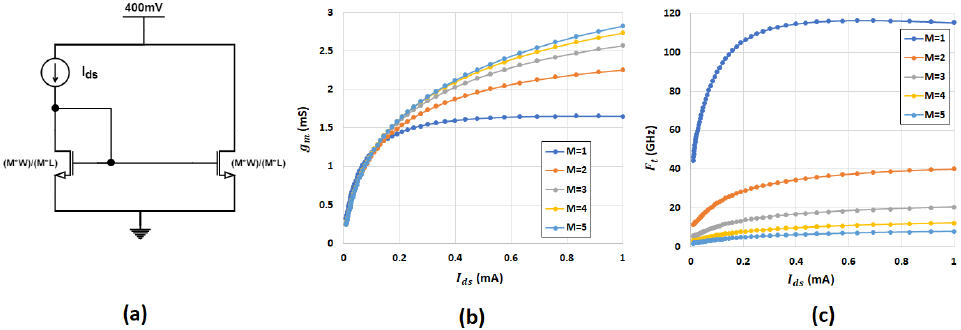
Figure 2. ( a ) Test bench to optimize and characterize g m and f T , ( b ) resulting g m plots, and ( c ) resulting f T